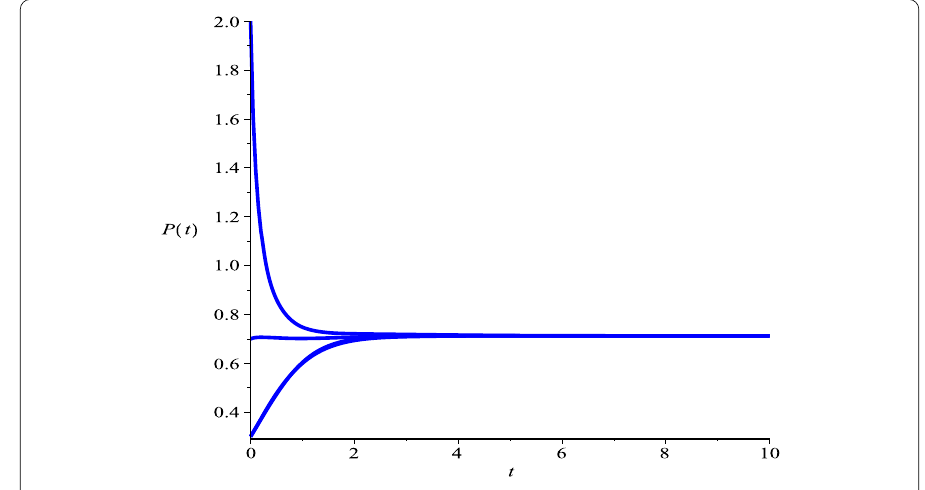
Figure 3 Dynamic behaviors of the second species in system (5.1). The initial conditions ( H